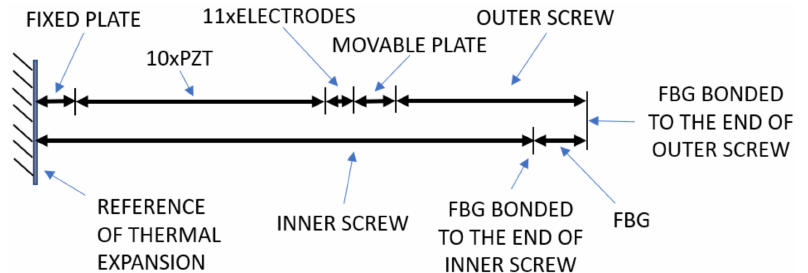
Figure 3. Diagram of the temperature compensation scheme. By choosing the material and length of the two screws, the distance between their ends is independent of the temperature (adapted from [7] with